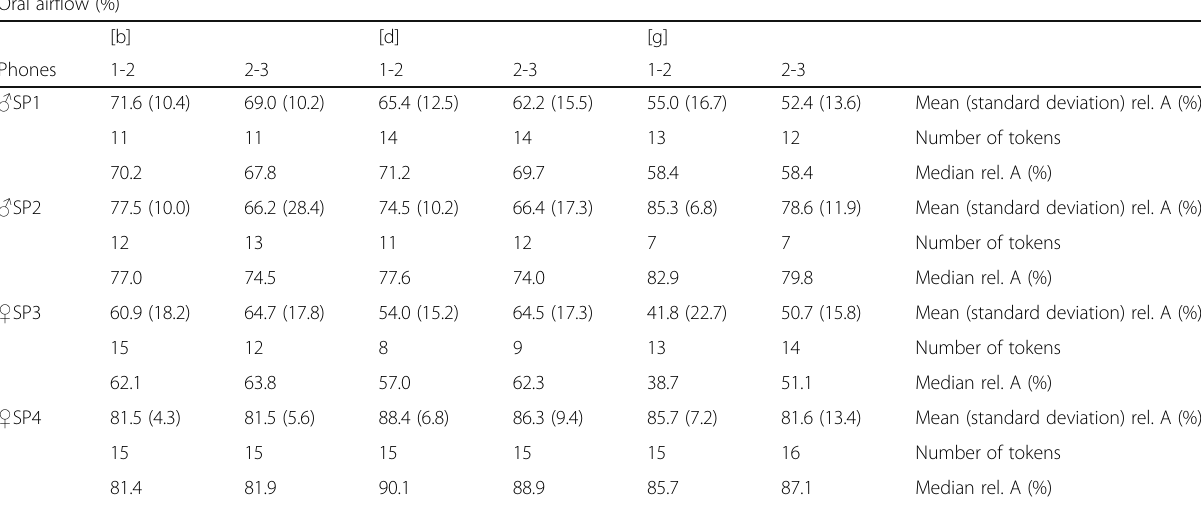
Table 8 Mean (standard deviation) relative values of oral airflow (A12 and A23), number of tokens and median relative values of oral